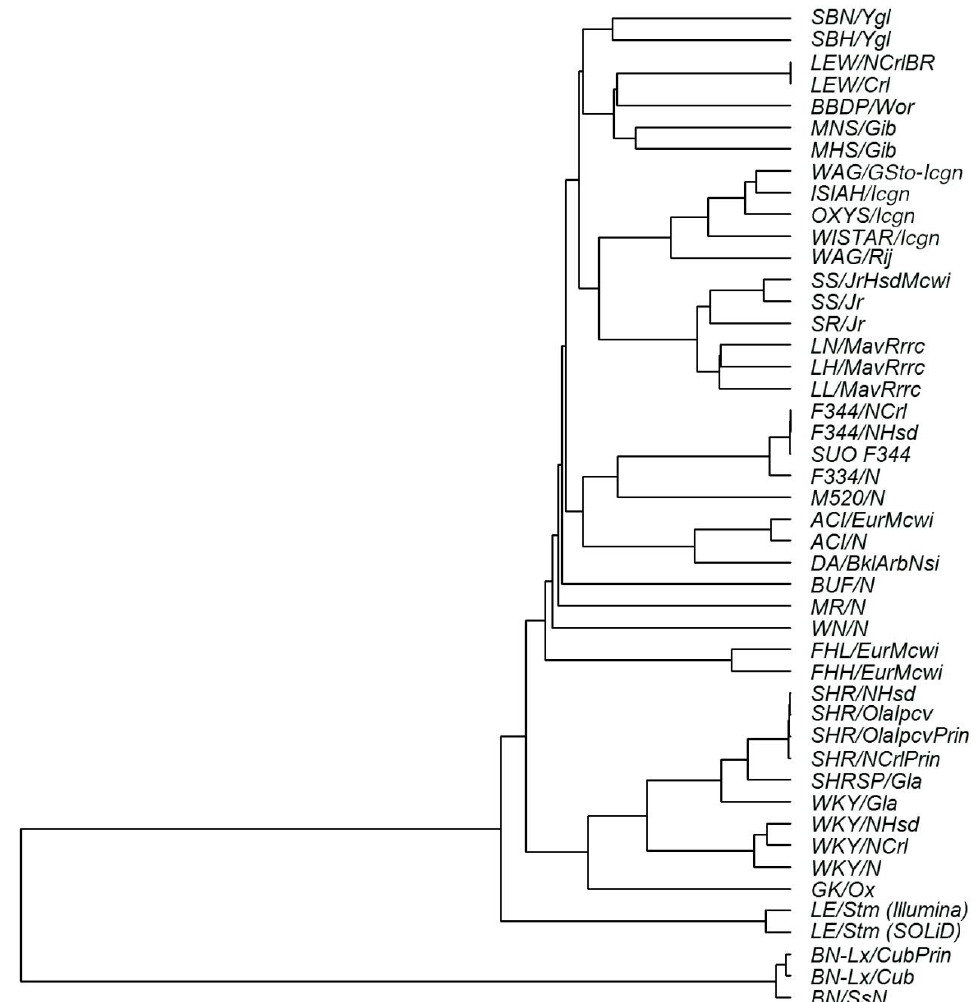
Figure 1. Analysis of genetic similarities of rat strains and substrains in terms of single-nucleotide polymorphisms (SNPs). The dendrogram is based on the identity of alleles by state. SNPs were identified in the transcriptomes of three tissues of OXYS/Icgn rats and in the corresponding loci of the WAG/GSto-Icgn, ISIAH/Icgn, and Wistar/Icgn rat transcriptomes or genomes available in the databases for the other 42 rat strains and substrains.